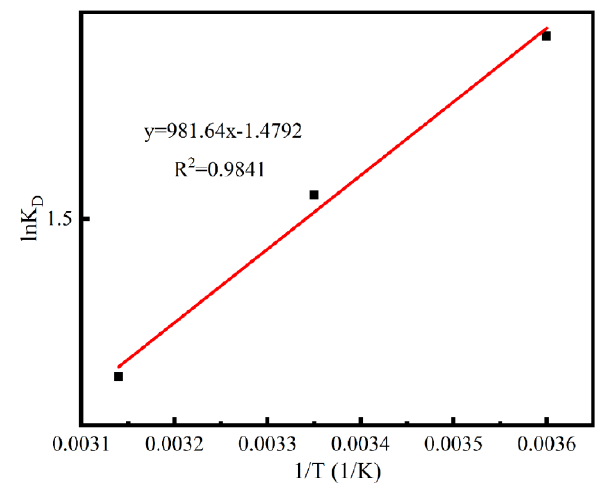
Figure 8. Plot of lnK D versus 1 / T for MB adsorption on the Ca-MOF / ABS / TPU 3D skeleton at different temperatures. Table 1. Thermodynamic parameters for the adsorption of MB on the Ca-MOF / ABS / TPU 3D skeleton.